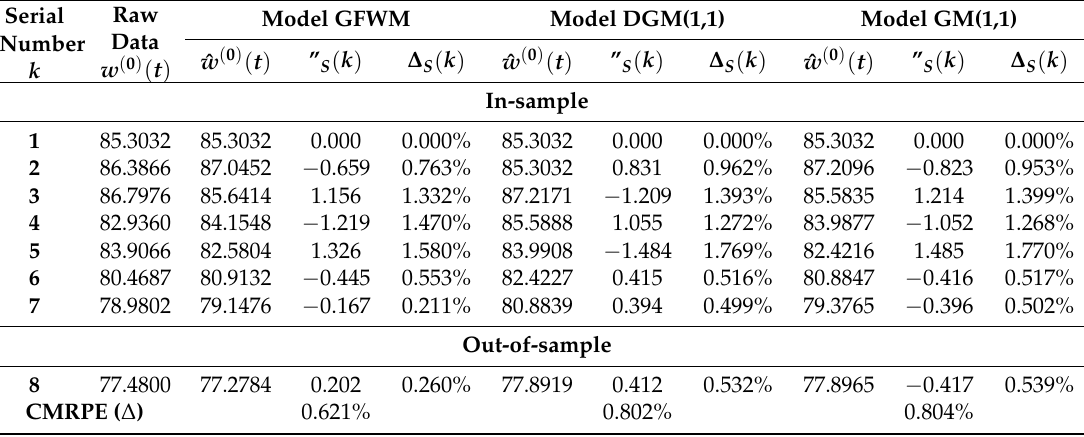
Table 3. Simulation/forecasted values and errors of GFWM, DGM(1,1), and GM(1,1).